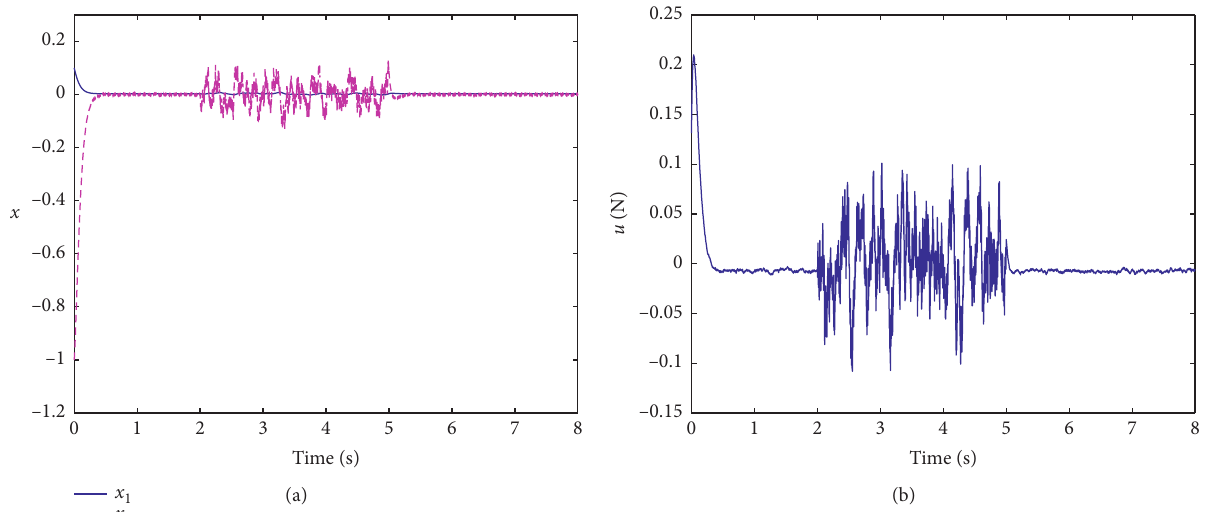
Figure 6: Temporal evolution of the states x and x of the nonlinear system (15) and the saturated affine state-feedback control law u for the 1 2 � 1. Here, the system is subject to randomly time-varying uncertainties and also a randomly time-varying external saturation level u max disturbing torque w . Moreover, δ a,b,c,d,e � 1.